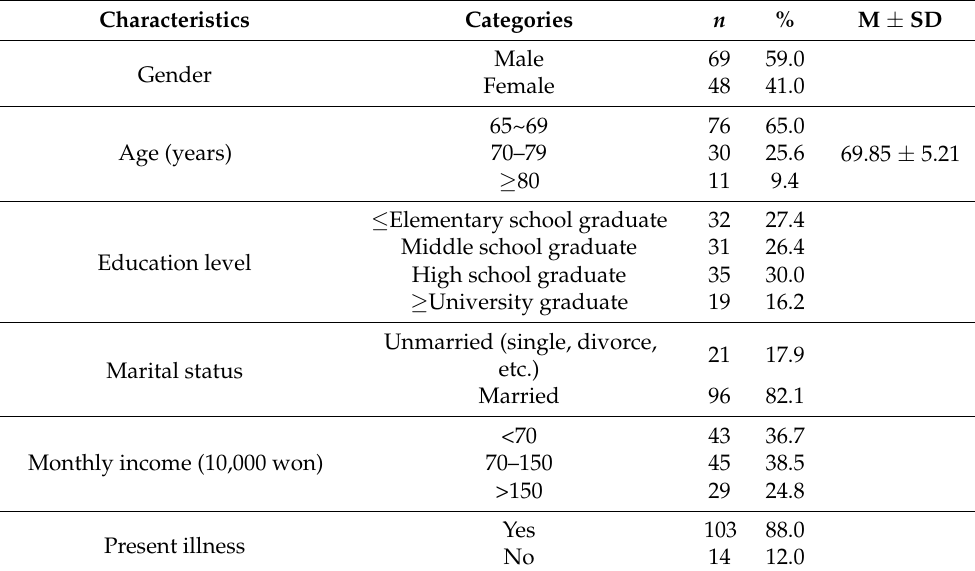
Table 1. Demographic and oral health characteristics ( n =